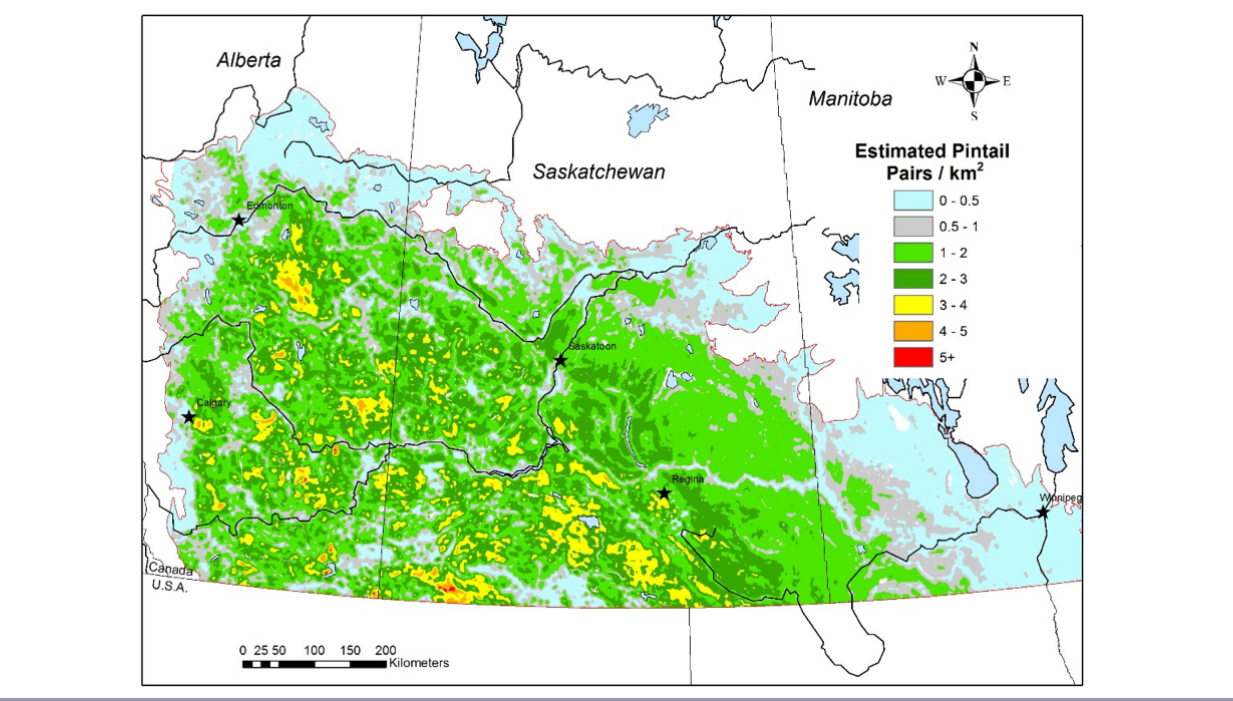
Fig. 1 . Estimated long-term average (1961–2009) breeding Northern Pintail ( Anas acuta ) pair density (pairs/km²) as a function of wetland, upland, and geographic covariates in the Prairie Pothole Region (PPR; outlined in red) of Canada (Devries